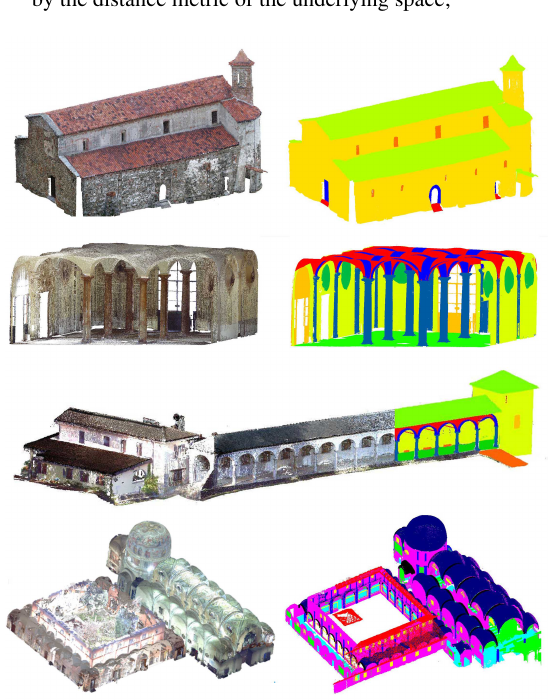
Figure 4. Visualization of architectural classes definition. On the left the scanned object, on the right each specific